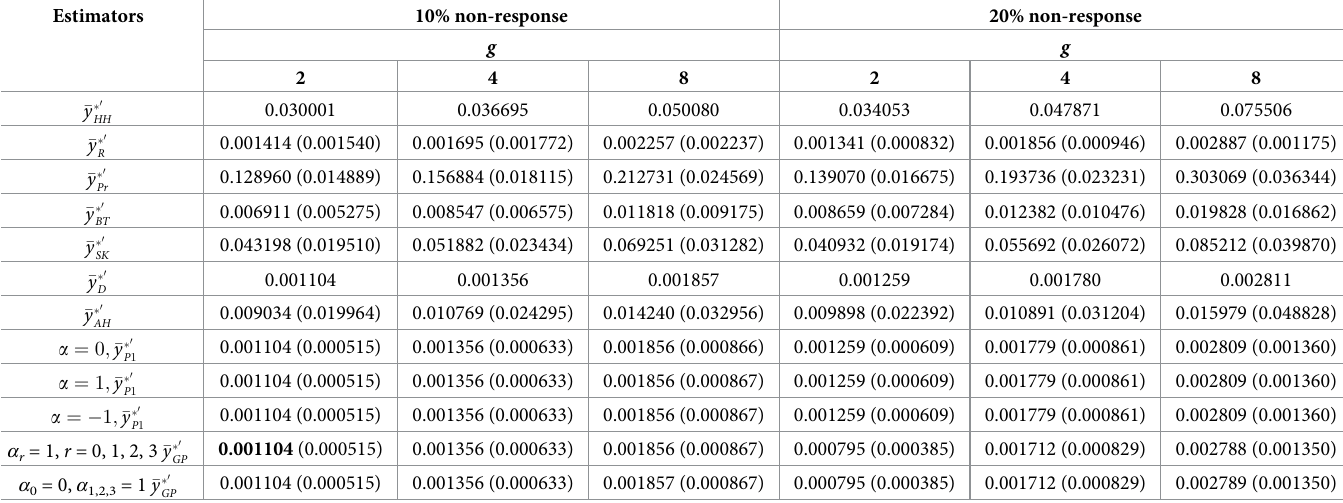
Table 7. Mean squared error and | Bias | (in brackets) values for different estimators for Population III without measurement error.